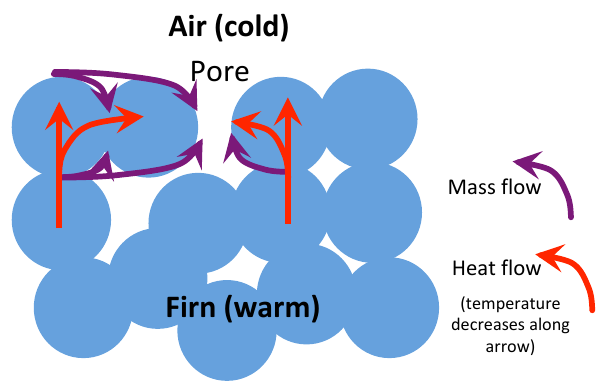
Figure 17. Schematic illustrating possible mass and heat trans- ports during formation of a single-grain glazed crust, when the near-subsurface is warmer than the surface. Heat flow is primar- ily through the grain structure (blue), so pores (white) in the surface layer will be colder than interconnected grains, favoring mass trans- port from the grains to those pores, increasing density of the surface